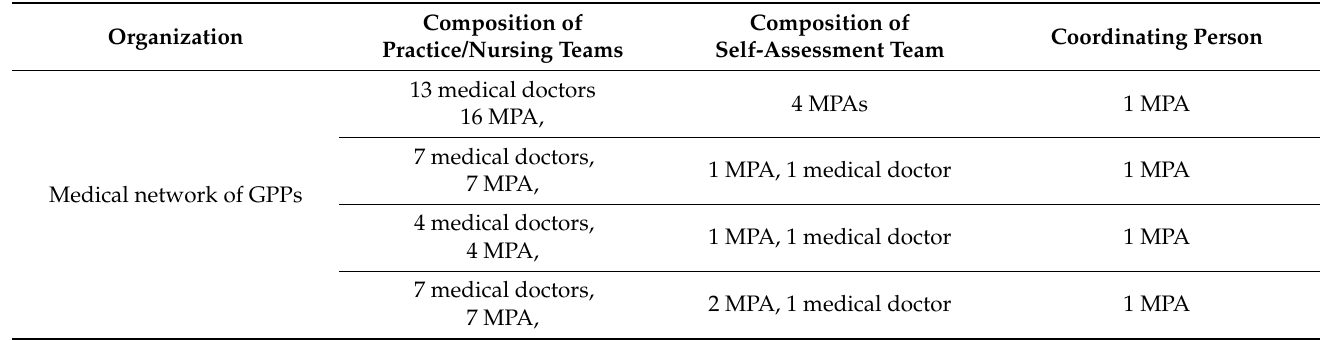
Table 3. Characteristics of the self-assessment